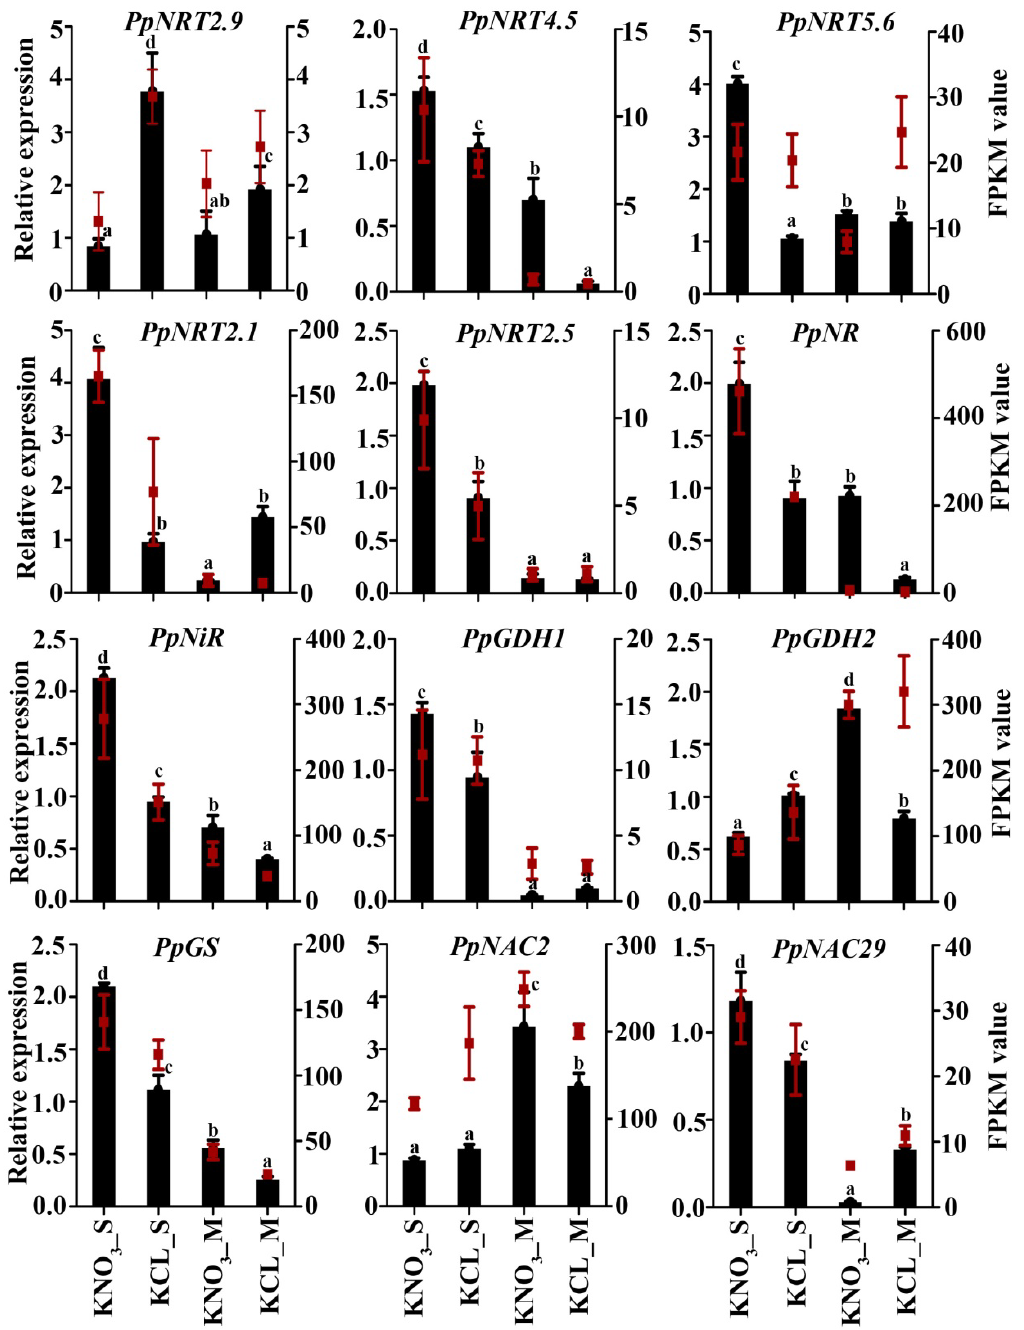
Figure 7. qRT-PCR validation of the KNO 3 induced fold changes detected in S and M using RNA-seq. The relative expression values determined by qRT-PCR are presented as black columns with the left Y axis as reference. The FPKM value of DEGs are represented as red scatters with the right Y axis as reference. Different lowercase letters indicate significant differences at p < 0.05 by one-way ANOVA with Duncan’s (D) multiple comparisons test for the relative expression values determined by qRT-PCR. Error bars show the standard error between three biological replicates ( n =